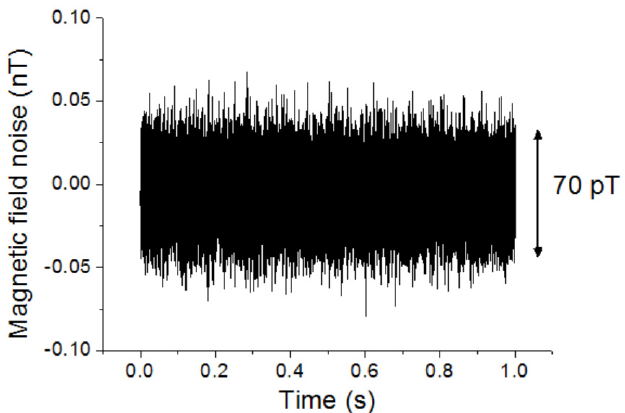
Figure 13. The magnetic field noise of the magnetic sensor at 630 Hz with the observation bandwidth of about 100 Hz.